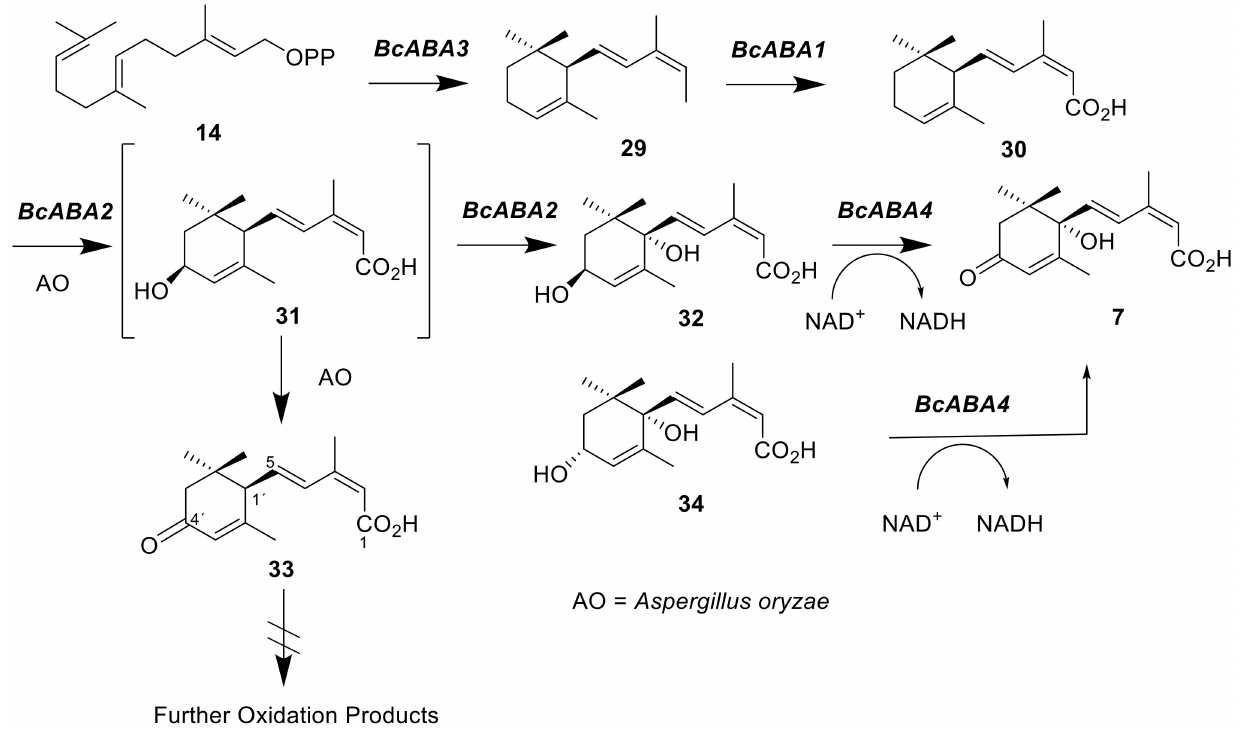
Figure 12. Biosynthetic pathway of 7 in B. cinerea